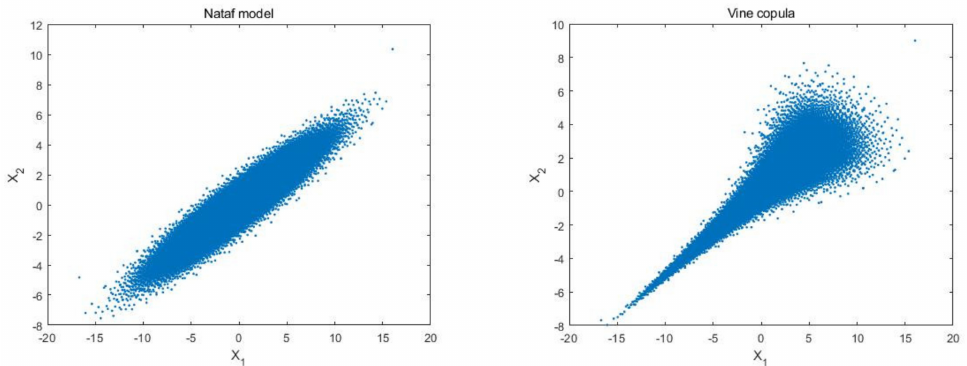
Figure 6. Sample distribution generated by two methods ( ( X 1 , X 2 ) , N = 2 15